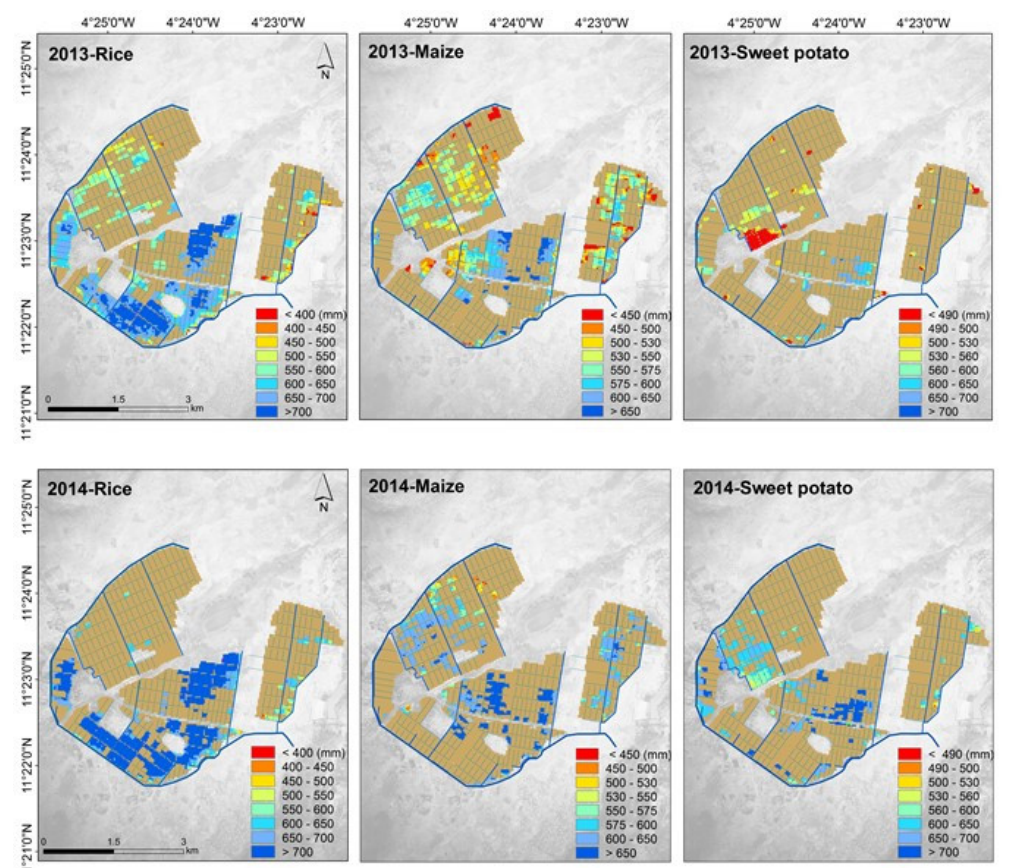
Figure 6. Seasonal ET a for rice, maize, and sweet potato plots across the Kou Valley irrigation scheme during the dry season production period in 2013 and 2014. Table 3. Ranges of estimated ET a and yields for paddy rice, maize, and sweet potato during the dry season production periods in 2013 and 2014. The change rates of estimated ET a and yields between 2013 and 2014 are provided. Rice Maize